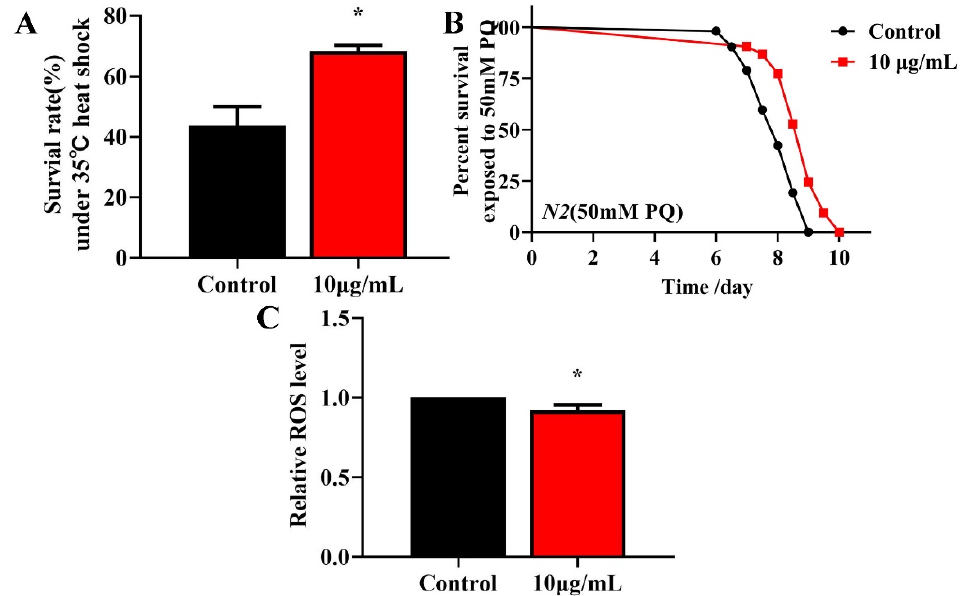
Figure 4. Effects of TG pretreatment on the stress resistance and ROS accumulation in C. elegans . ( A ) TG significantly increased the survival of worms under heat stress. ( B ) The worms were treated with or without TG and exposed to 50 mM paraquat. ( C ) Relative levels of ROS in C. elegans following the treatment with TG. TG decreased the ROS levels in the worms, evidenced by the quantification of the fluorescence intensity. The data were analyzed using a Student’s t-test. The values were shown as the mean ± SEM, * p < 0.05.